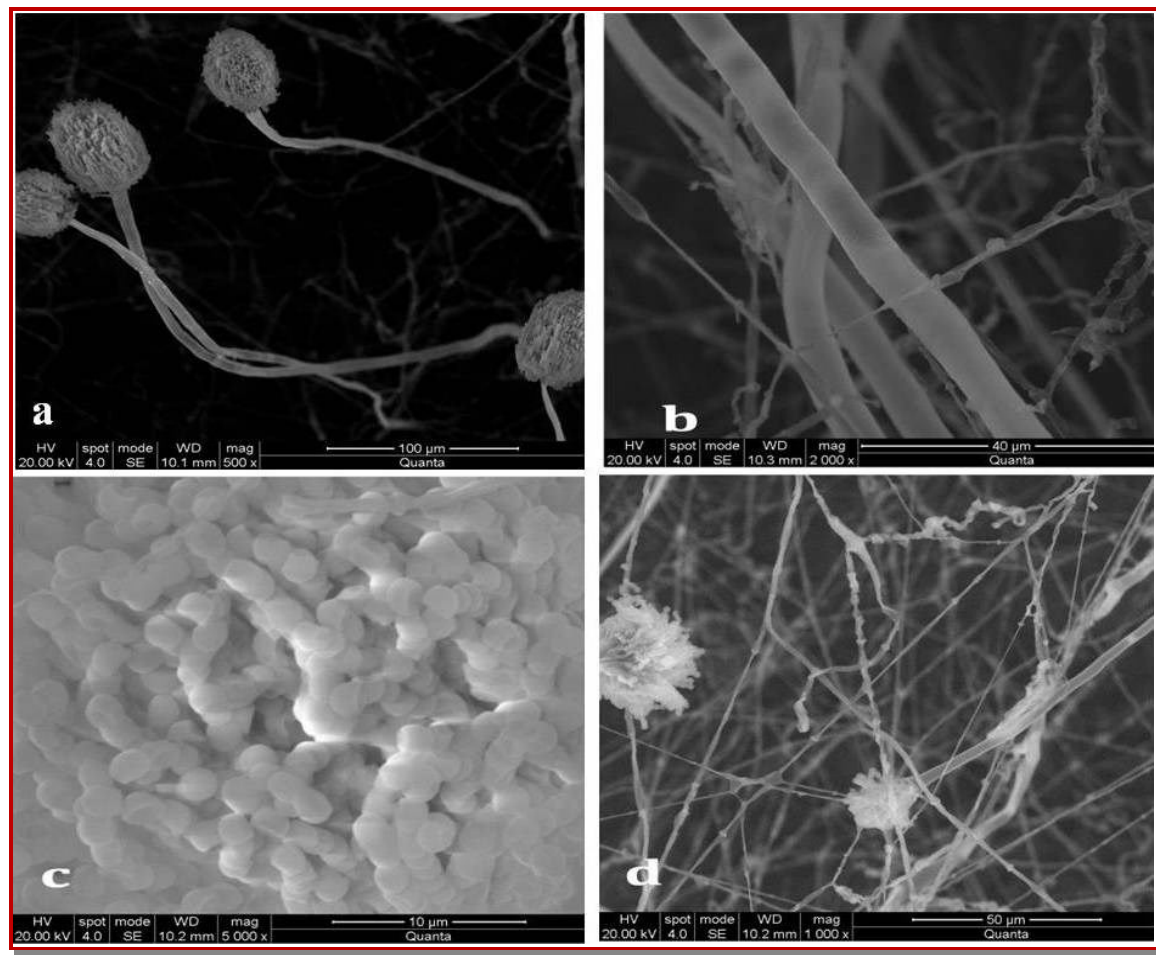
Figure 5: SEM images of Fusarium graminearum a,b - F. graminearum control; c, d - F. graminearum ethyl acetate extract treated